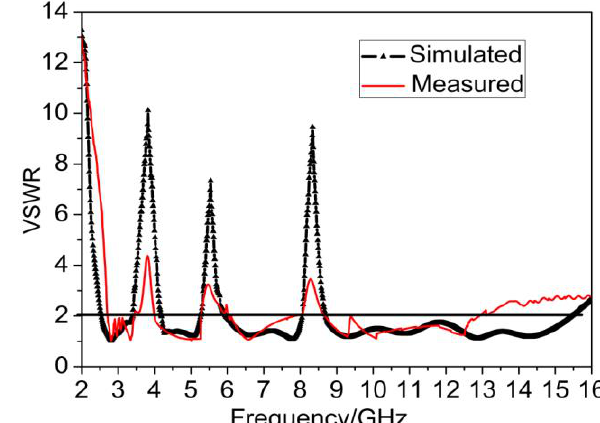
Figure 10: Geometrical & fabricated proposed CPW fed UWB antenna with reflector.